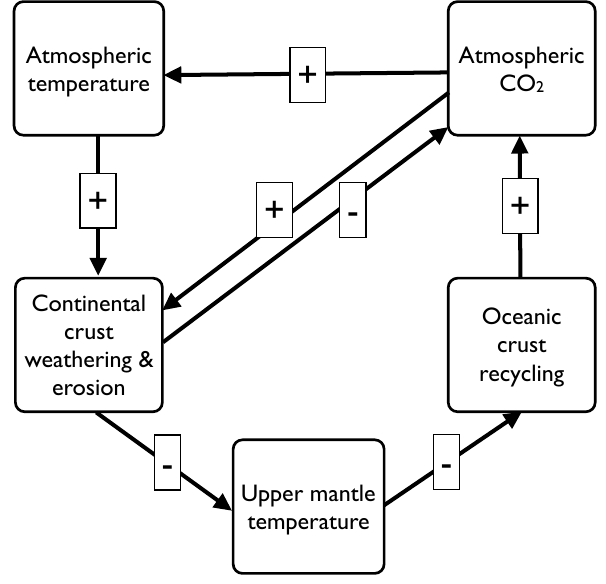
Fig. 14. Surface to interior interactions are shown schematically. Arrows denote the feedback relationships and their sign. The geo- logical carbon cycle is represented by the Oceanic crust recycling, Atmospheric CO 2 , Atmospheric temperature and Continental crust erosion boxes. We propose a new feedback between rates of con- tinental crust erosion and oceanic crust recycling via upper mantle temperature. Increasing rates of continental crust erosion would lead to a decrease in upper mantle temperature. If we assume the oceanic crust recycling relaxes back to a state of maximum power generation, an increase in upper mantle temperature would lead to a decrease in rates of crust recycling and outgassing of CO 2 , see Fig. 13. It is important to note that these different feedback mecha- nisms operate over a wide range of